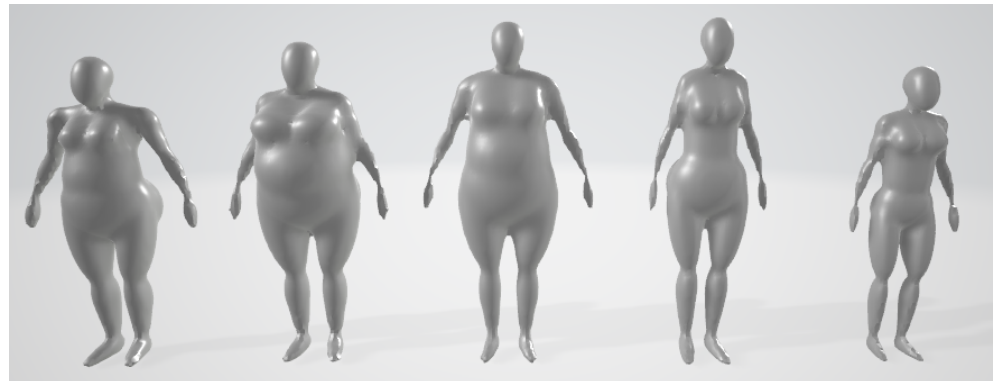
Figure 23. Smooth representations of the Cushion-based Mannequins. These representations are not the aim of the present manuscript, rather for future